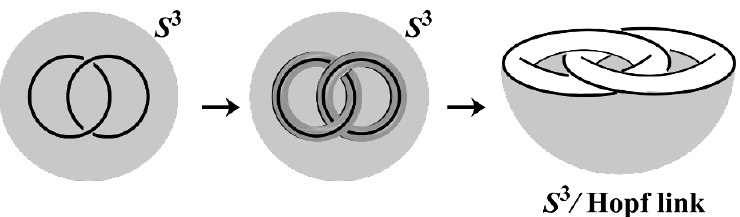
Figure 6 . Figure showing the construction of Hopf link complement. Removing a tubular neigh- borhood around Hopf link embedded in S 3 results in Hopf link complement which is a manifold with two torus